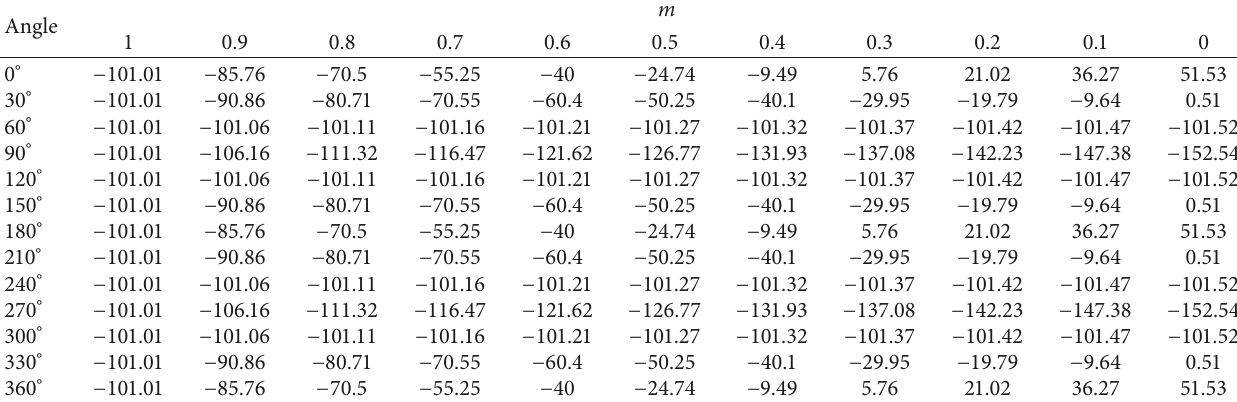
Table 1: Circumferential stress σ